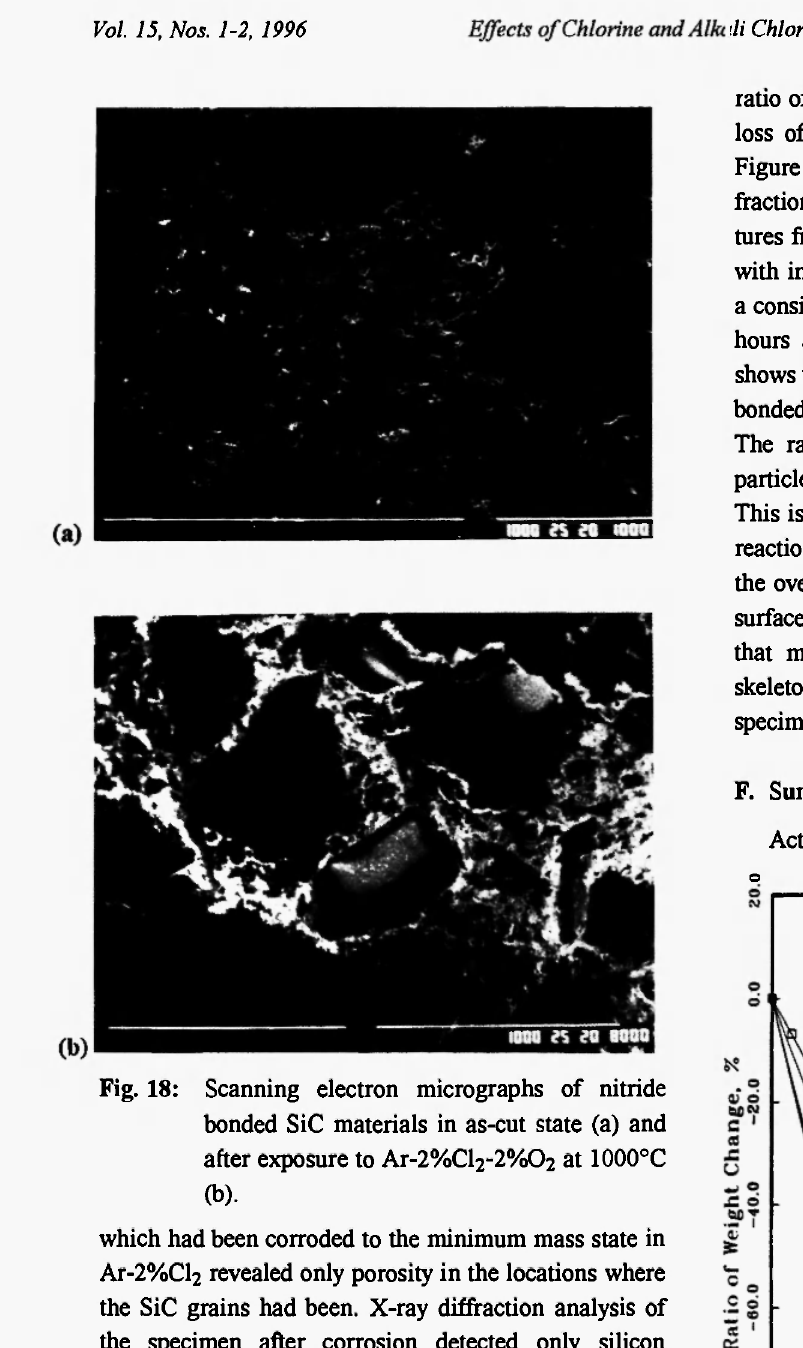
-2%0 at 1000°C 2 2